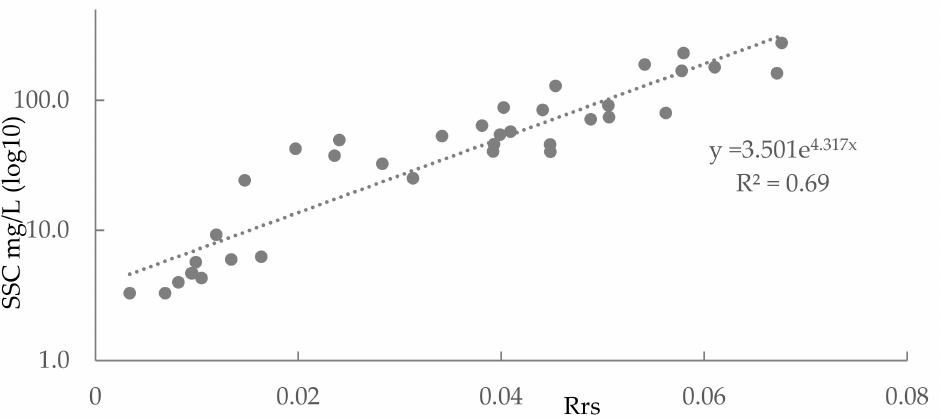
Figure 8. Simulated natural logarithmic model between in situ spectral data and measured SSC, and the main reflectance is between 0.02 and 0.06, matched to the OLI’s Band 4, and the corresponding sediment data is 4–189 mg L − 1 .